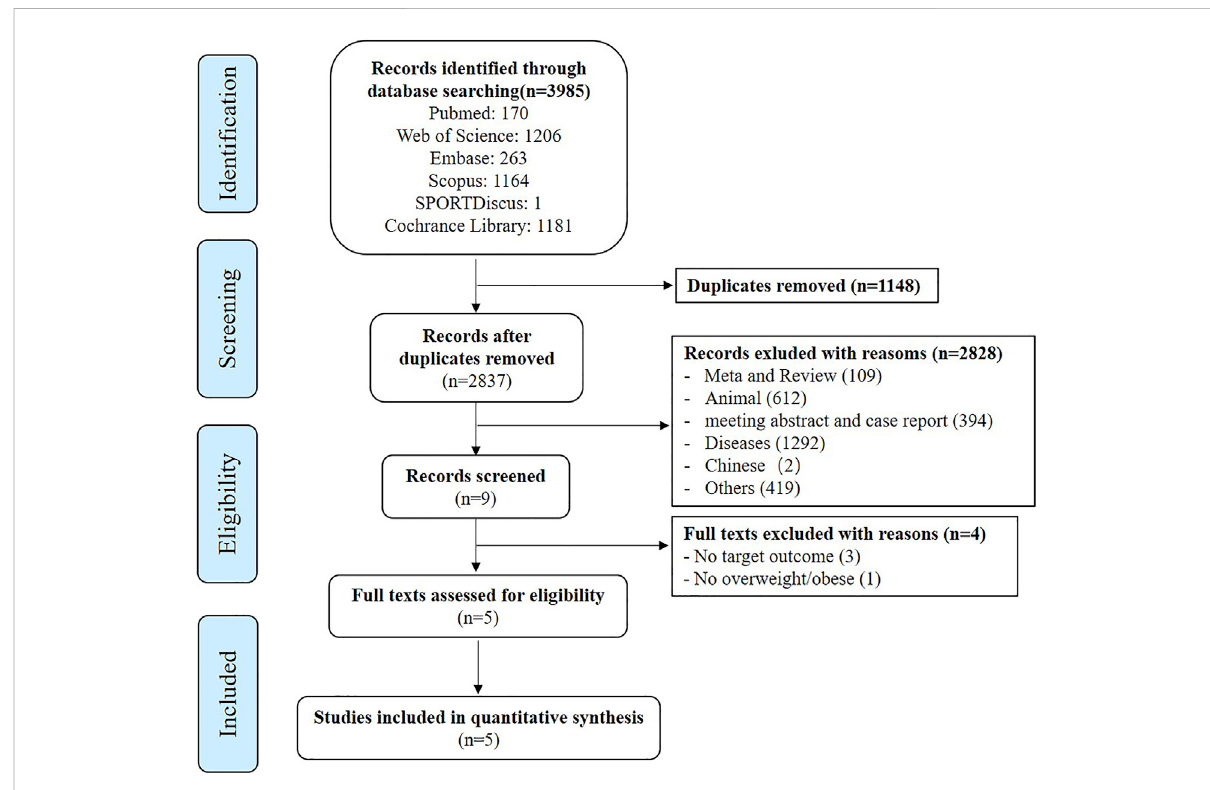
FIGURE 1 Flow diagram demonstrating the step by step process of article elimination to fi nd the fi nal articles to be included.